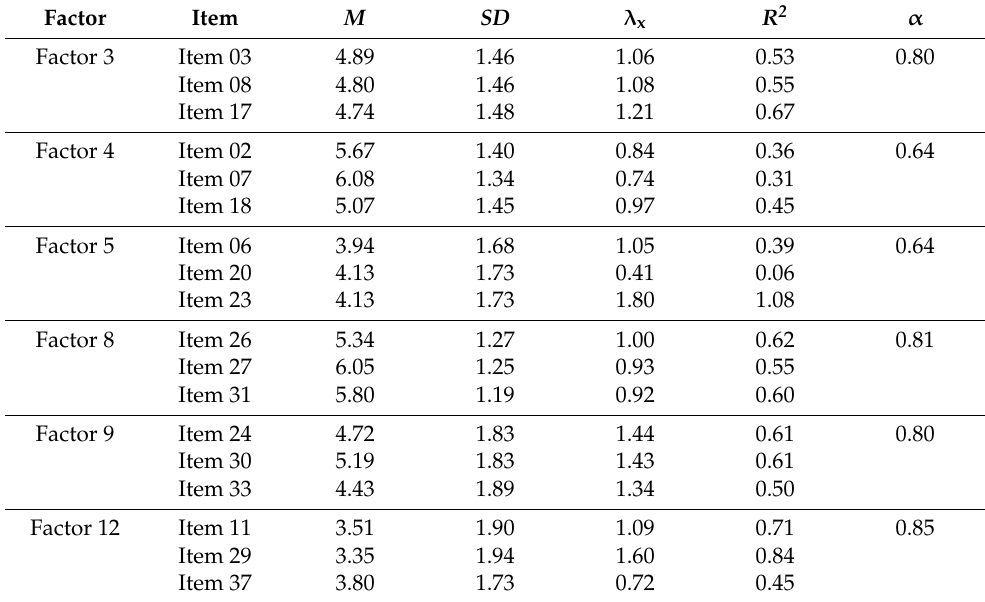
Table 3. Descriptives, confirmatory factor analysis estimations, and internal consistency coefficients for a six-factor model in general population ( n =